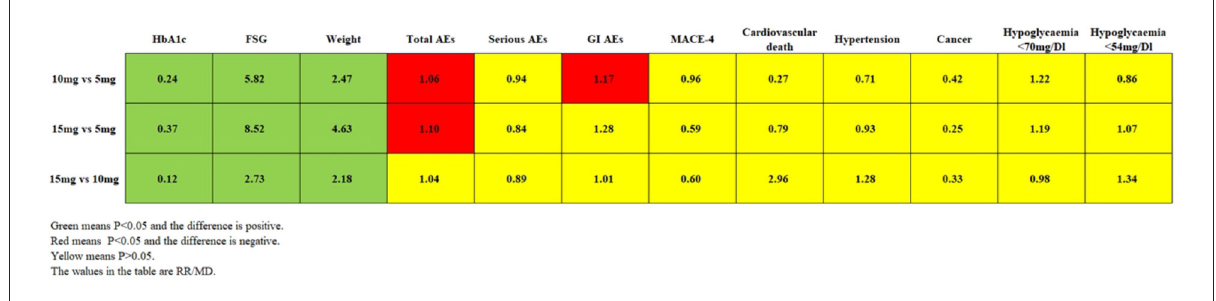
FIGURE6 Comparison of each outcome for the different dose of